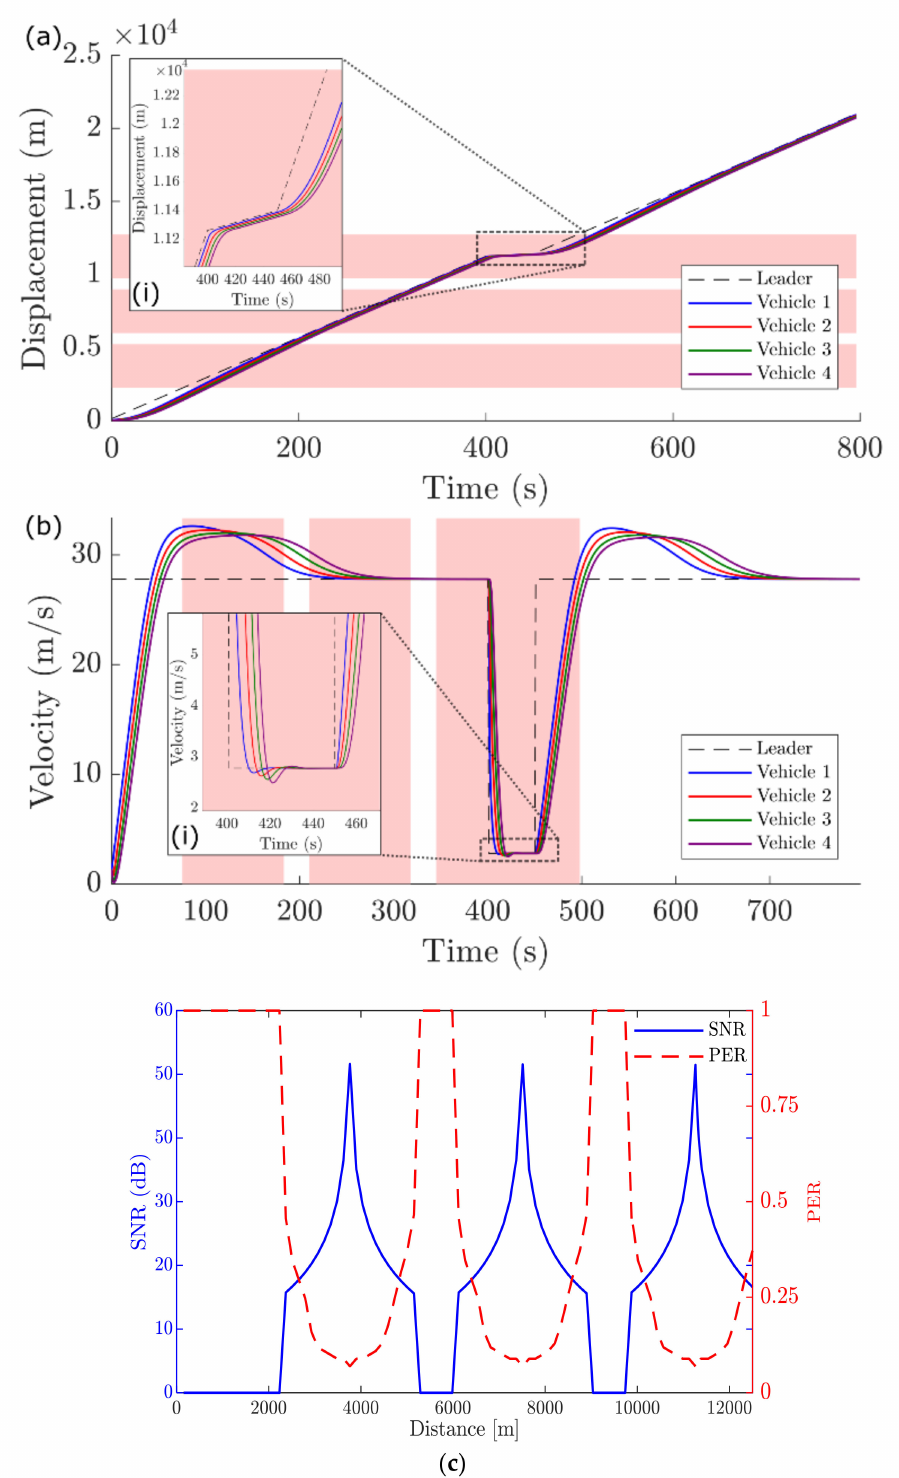
Figure 8. Case II vehicle platoon motion as described in Section 3.4: ( a ) Displacement of the vehicles over the simulation time. The inset shows a magnified image of the vehicle displacements as the platoon encounters a dynamic message from the RSU’s; ( b ) Velocity of the vehicles over the simulation time. The inset shows a magnified image of the car velocities as the platoon encounters a dynamic message from the RSU’s; ( c ) Variation of SNR and PER as the platoon moves along the road. Leader is the platoon